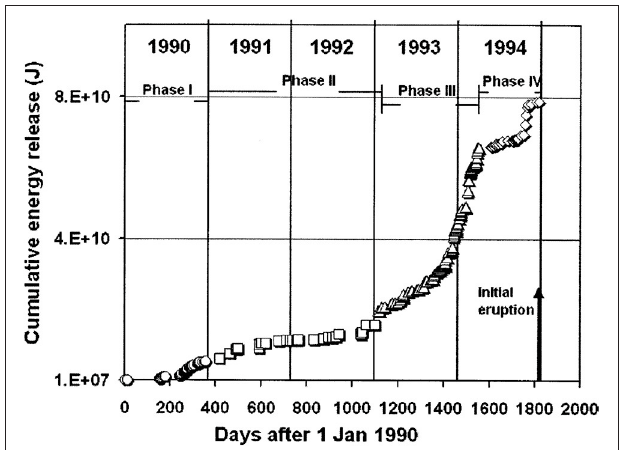
FIGURE 6 | Cumulative energy release from volcanotectonic earthquakes recorded at Popocatépetl, 1990–1994. Note the rapid increase in energy release from late 1993 to early 1994. De la Cruz-Reyna et al. (2008), Copyright 2008, with permission from